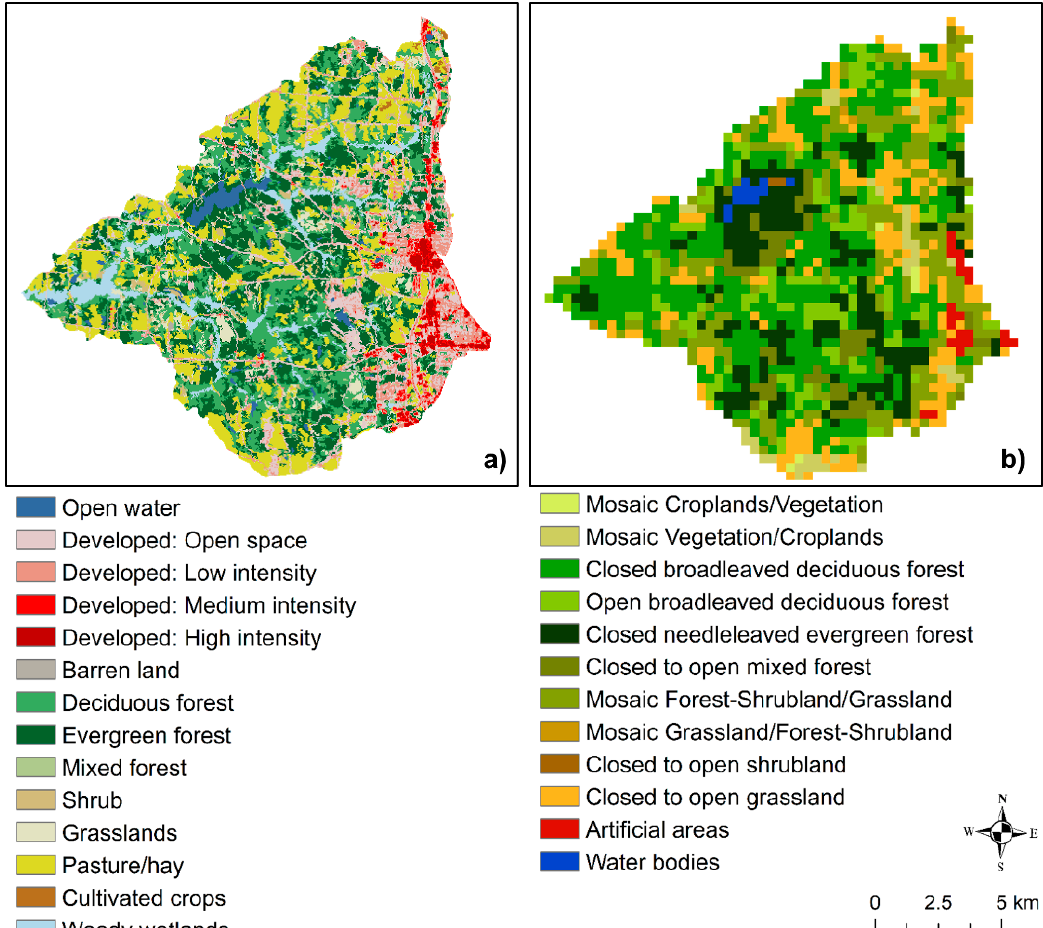
Figure 2. The Wildcat Creek watershed represented by the NLCD 2006 ( a ) as a land cover map with 30 m spatial resolution (https://www.mrlc.gov/nlcd2006.php), and by the GlobCover 2005 ( b ) with 300 m spatial resolution (© ESA 2010 and UCLouvain. http://due.esrin.esa.int/page_globcover.php).